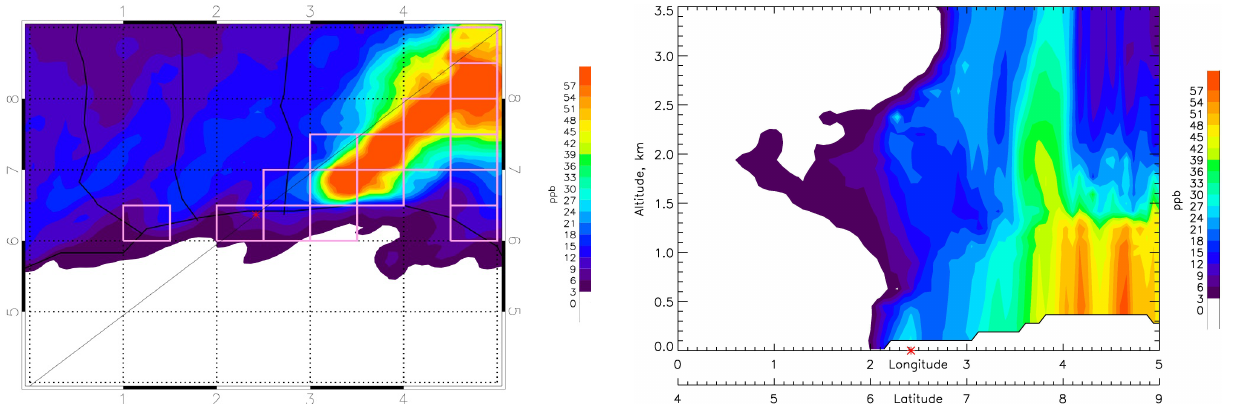
Fig. 10. Horizontal and vertical cross section of anthropogenic tracer mixing ratio in ppbv on 19 August, 13:00UTC from the 8km-anthro BOLAM simulation. Solid line on the 900hPa cross section (left panel) indicates the position of the vertical cross section (right panel). Cotonou is indicated by the red asterisk. CO emissions > 0.5µgm − 2 s − 1 in pink squares.